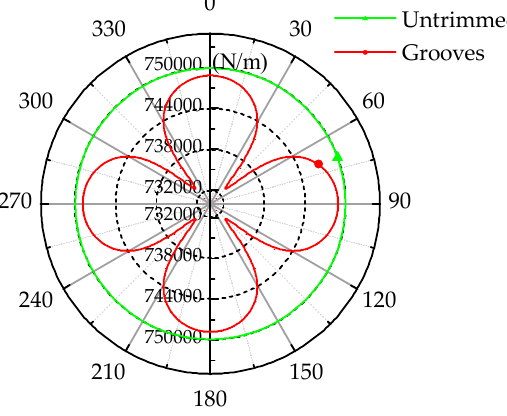
Figure 8. Rigidity condition of the resonator.